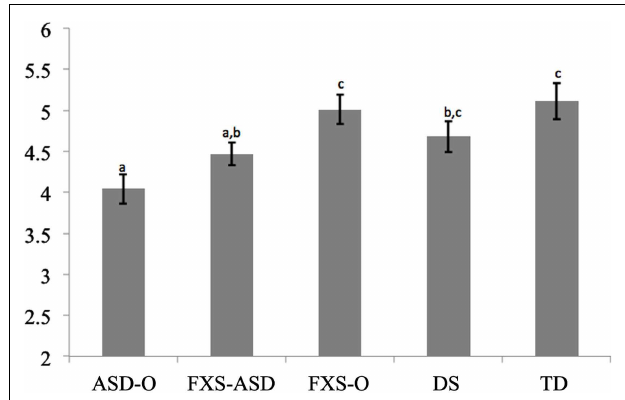
FIGURE 1 | ModelAdjusted Pragmatic Judgment Scores on the CASL. Notes: groups not sharing superscripts are significantly different from each other ( p < 0.05). F for Diagnosis (4, 107) = 4.39, p <